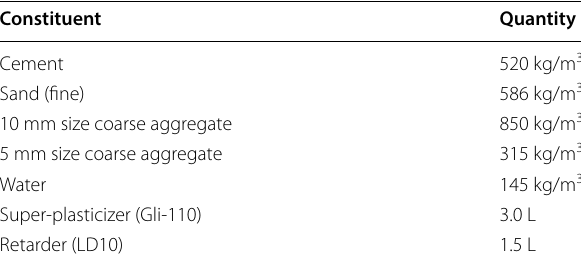
Table 1 The constituents of the plain concrete mix.